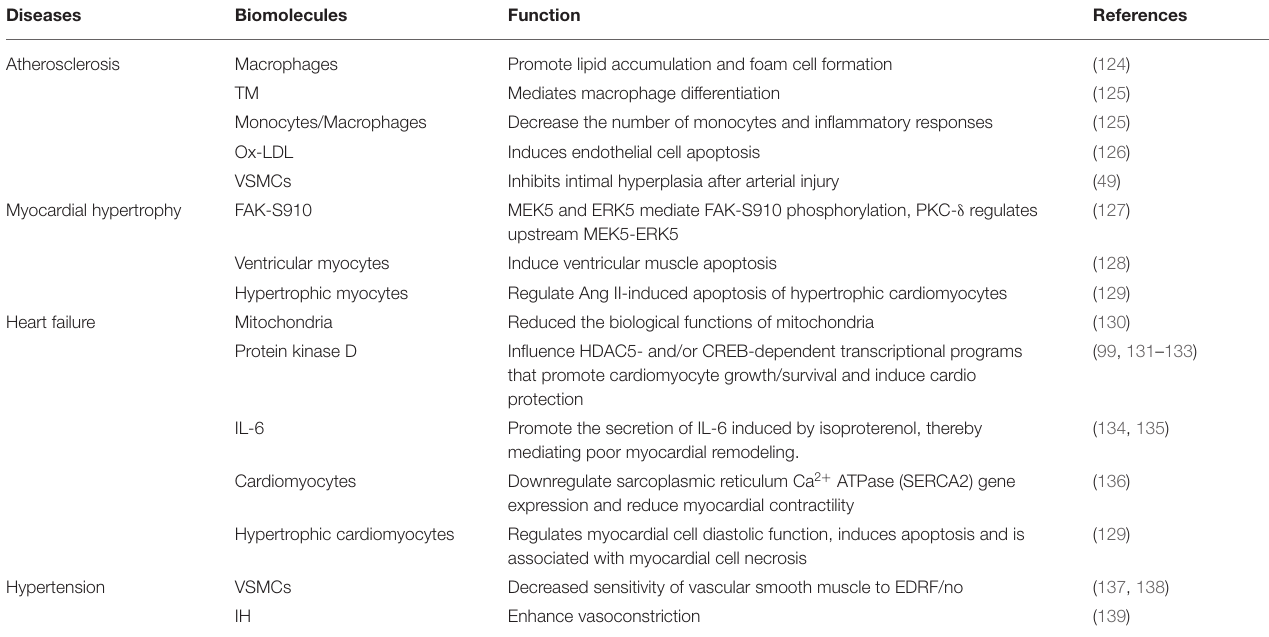
TABLE 2 | The mechanism of PKC- δ in different cardiovascular